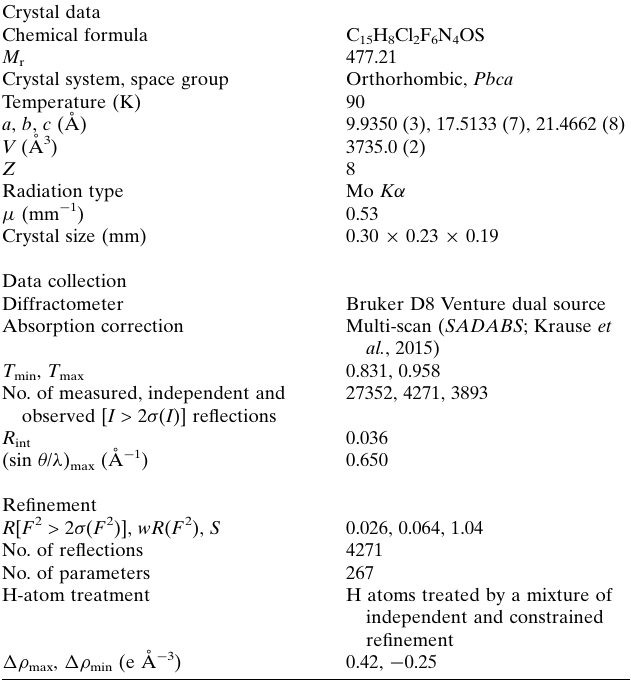
Table 4 Experimental details. Crystal data Chemical formula